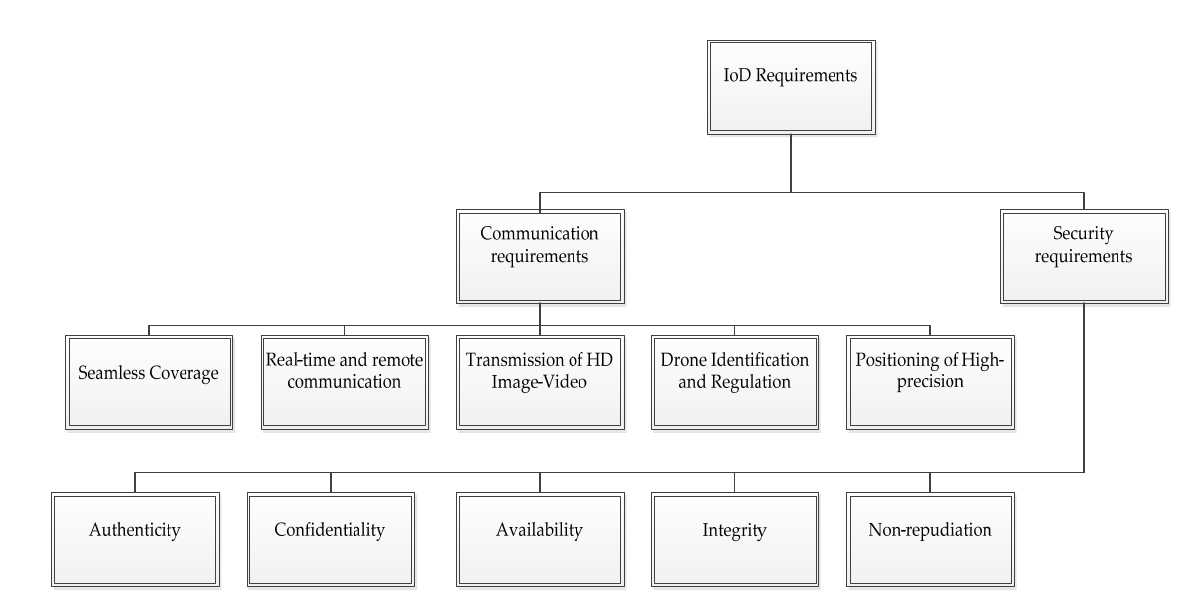
Figure 2. The key requirements of IoD.